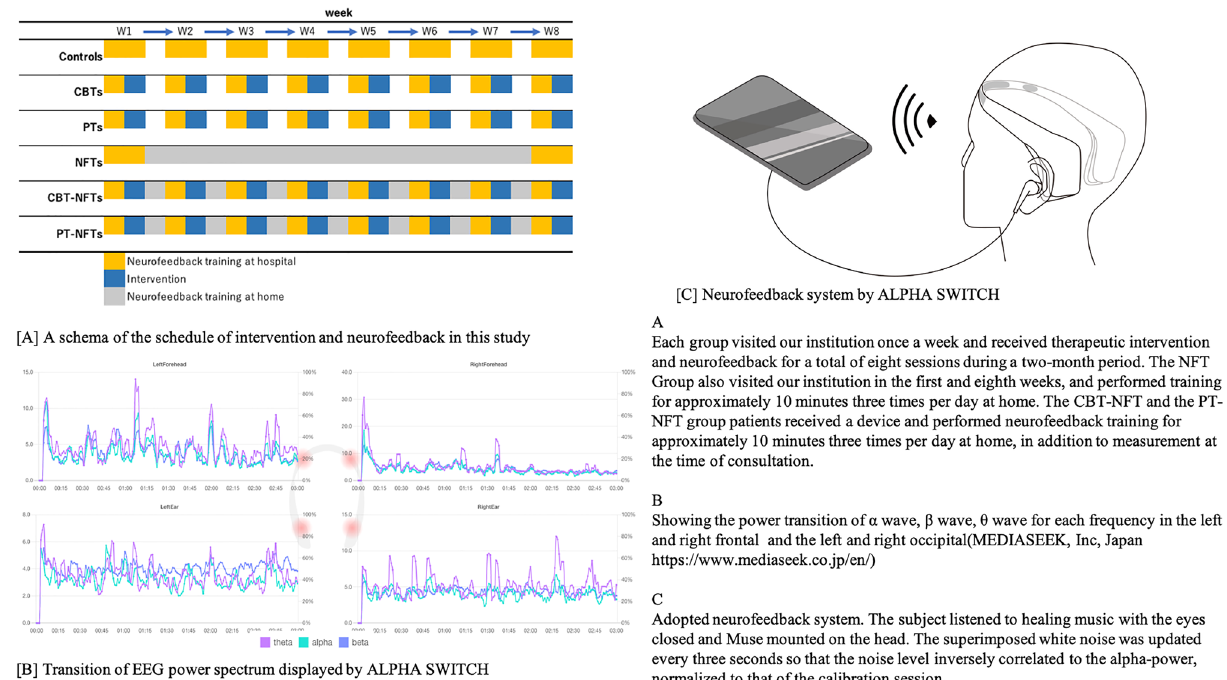
Figure 1. A schema of the schedule of intervention and neurofeedback training in this study and the neurofeedback